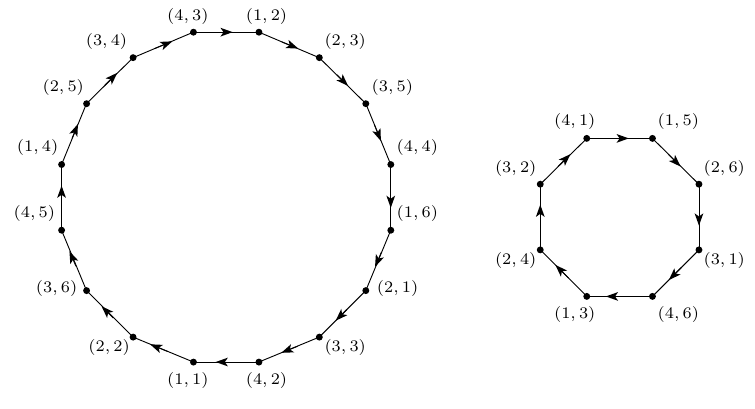
⊗ h Γ obtained in Example 4